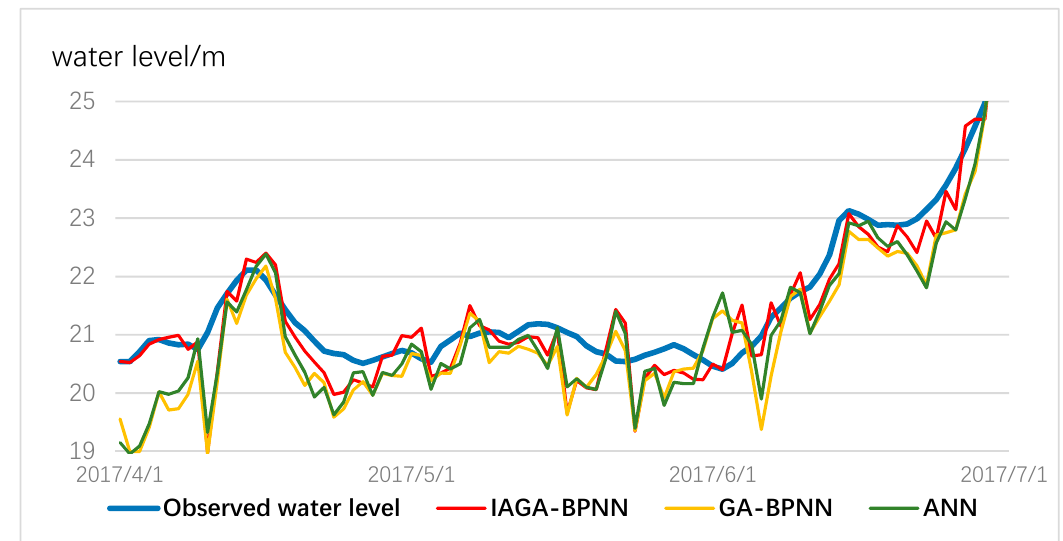
Figure 9. Comparison results for the three models for water-level prediction from April to June 2017.